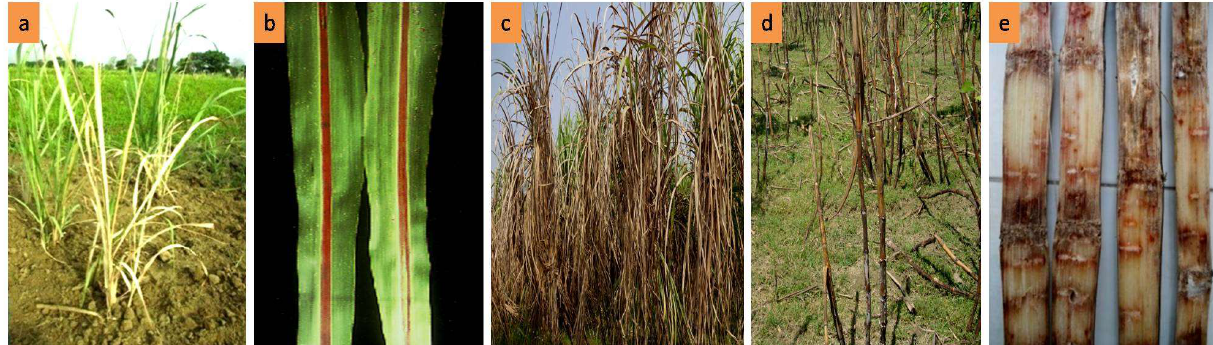
Figure 1. Typical Red rot disease symptoms ( a ) Tiller red rot ( b ) Lamina red rot ( c ) Red rot infected field ( d ) Stem red rot ( e ) Stem red rot internal symptom. Table 1. Description of C. falcatum Went isolates collected from various sugarcane growing regions of Bangladesh used in this study. SL